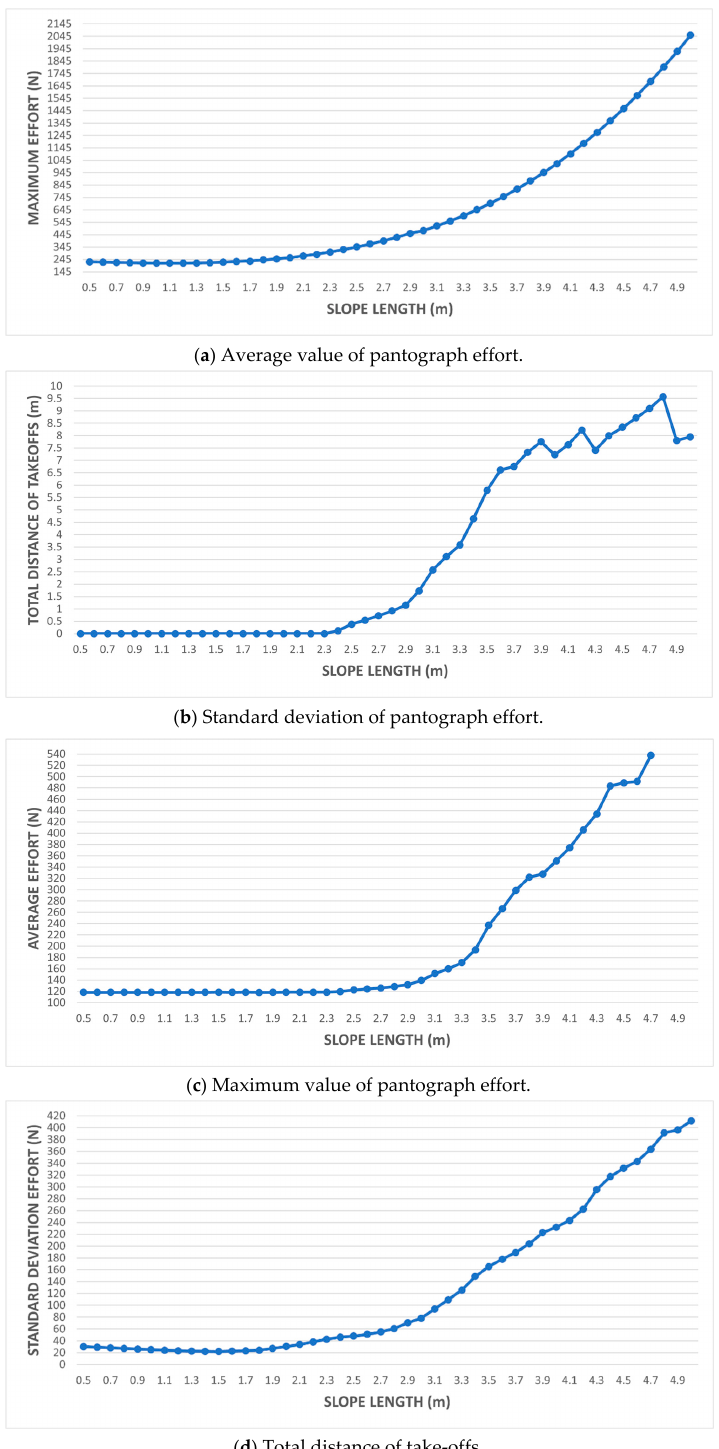
Figure 14. Graphs of simulation 4. Variation of the length of the overlapping span in the interval from 0.5 to 5 m and slope height 0. Normal spans length of 5 m. ( a ) Average value of pantograph